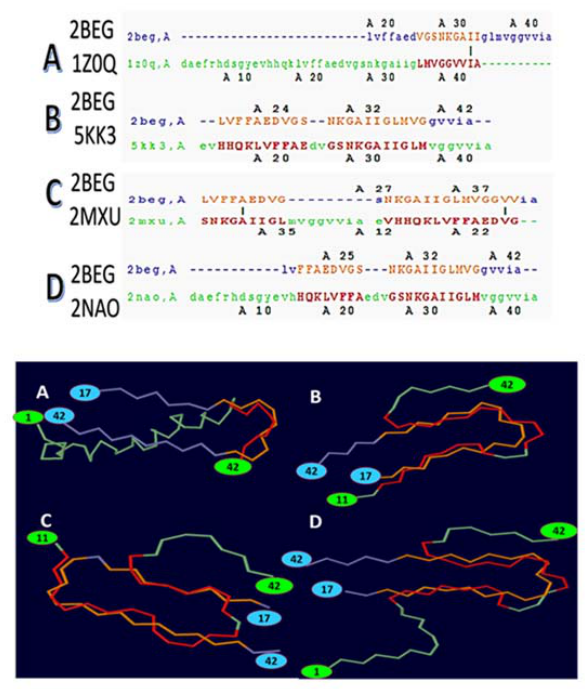
Figure 3. Alignment of the 2BEG structure (chain A; 17–42) with different structures. All the alignments show the 2BEG chain A in blue. ( A ) 2BEG chain A with 1Z0Q chain A; ( B ) 2BEG chain A with 5KK3 chain A (11–42); ( C ) 2BEG chain A with 2MXU chain A (11–42); ( D ) alignment of 2BEG chain A with 2NAO chain A (1–42).